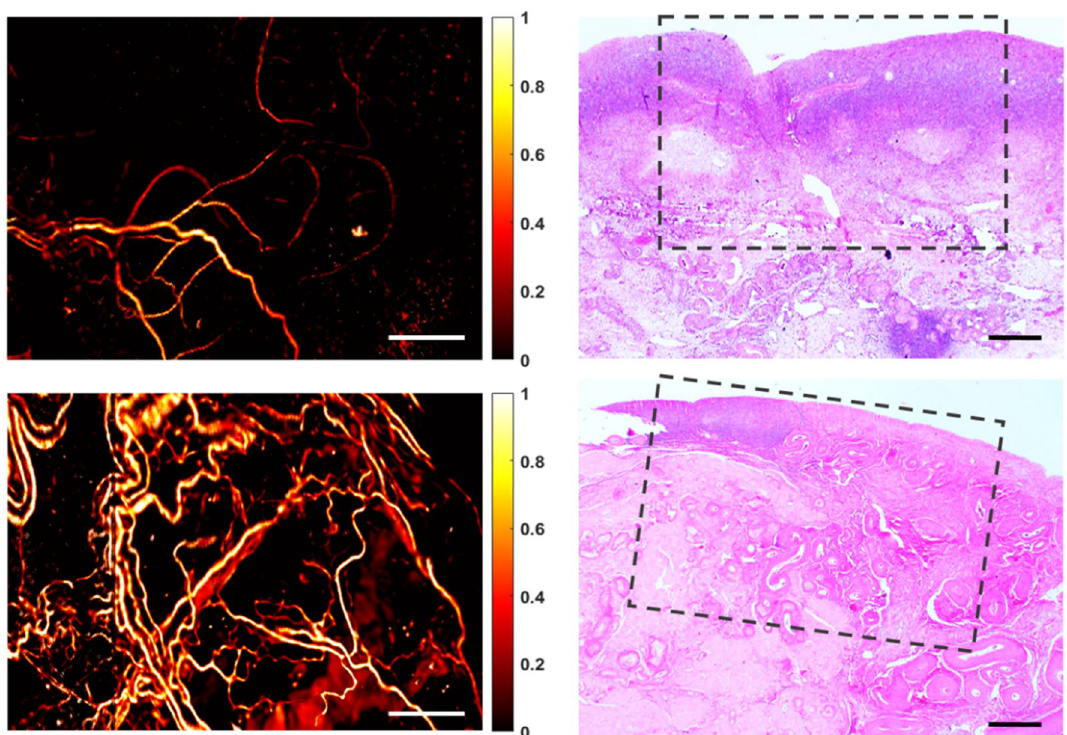
Figure 2. Vasculature of normal ovaries and representative H&E histological images: the ovarian cortex (top) and the venous plexus (bottom). Scale bar: 500 μm. Note that the qualitative comparison of this example and the following examples, Figs. 3, 5 and 6, is based on representative H&Es obtained in the approximate area imaged with the OR-PAM. The need for tissue fixation, processing and sectioning in the pathology laboratory places a limit on our ability to exactly match an H&E section with the area imaged by OR-PAM on fresh possibly because there were only four fibromas in the data set. In ovaries with malignant lesions, a significant increase in mean vessel diameter and decrease in local tortuosity were observed, suggesting the loss of fine capillary-level vasculature. A slightly decreased vascular definition and directionality suggested a more disorgan- ized vasculature inside malignant lesions. Two types of benign fallopian tube pathologies, paratubal cysts and salpingitis, were observed. As shown in Fig. 8, a significantly reduced local vascular tortuosity/branchedness was observed ( p = 0.0004) in fallopian tubes with benign lesions compared to its normal distribution, alongside a marginal increase in mean vessel diameter ( p = 0.0784). However, no statistical significance was found for other vascular features. Only one fallopian tube in our data set was diagnosed as malignant, i.e., metastatic high-grade serous carcinoma of endometrial origin.